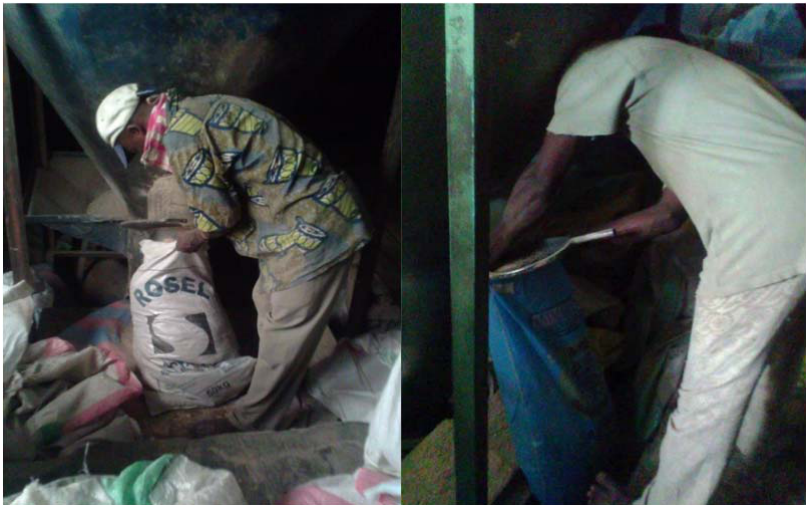
Figure 5. Discharge operation; filling bags with feed (left), opening discharge gate